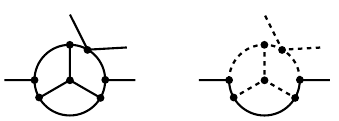
Figure 5 . One example of a non-genuine but (cid:12)nite topology (to the left), generating the diagram on the right. See